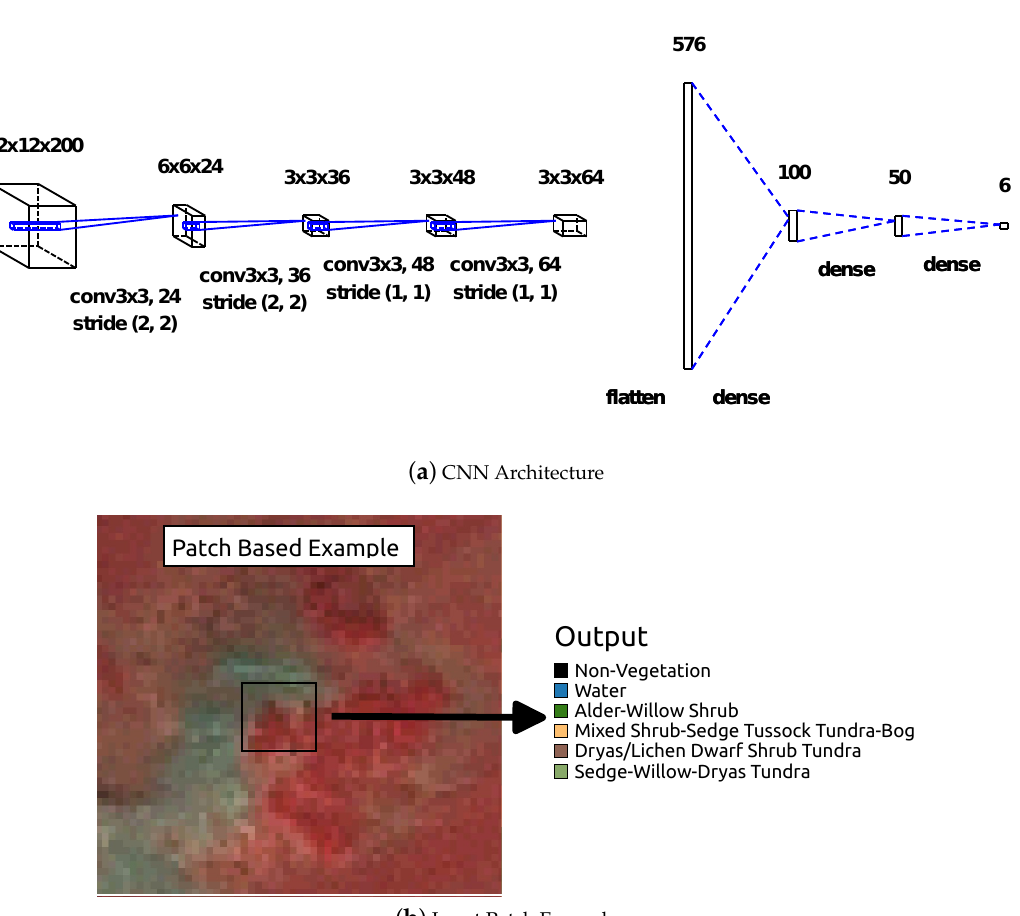
Figure 3. ( a ) CNN architecture used in the study, showing an example 12 × 12 image patch (with 200 bands) presented as the input. This is convolved with 24 different 1st layer filters, with a kernel size of 3 × 3, using a stride of 2. Similar operations are repeated linearly in the following layers, increasing the filter size as the image patch decreases in size. The last three layers are fully connected, taking features from the top convolutional layer as inputs. The final layer is a softmax function, corresponding to the number of vegetation classes (6). ( b ) Example 12 × 12 image patch input into the CNN with the output corresponding to a single